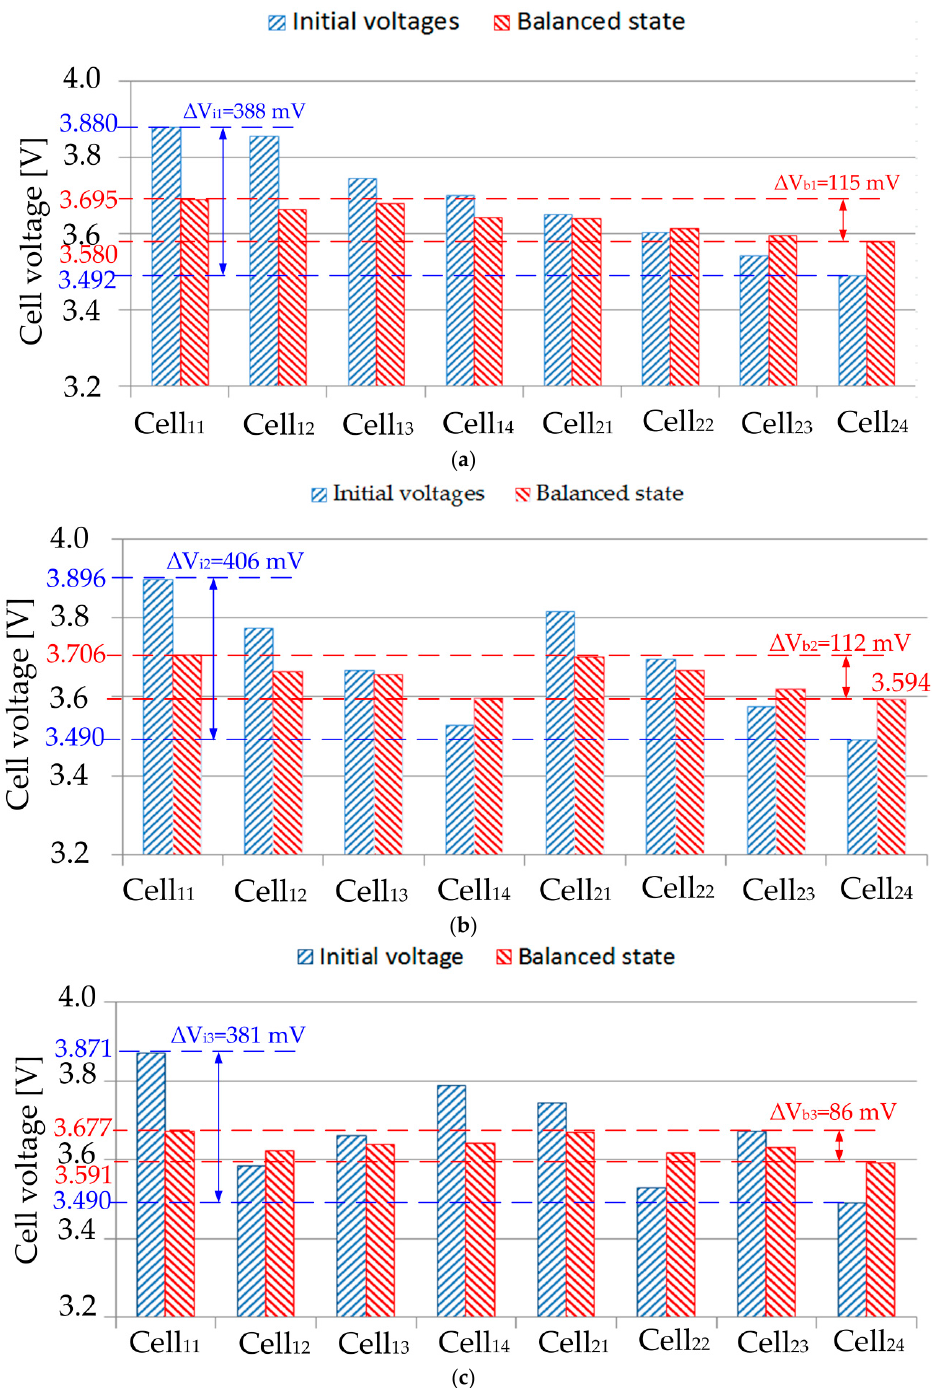
Figure 14. Initial and balanced state voltages: ( a ) Case 1; ( b ) Case 2; ( c ) Case 3.